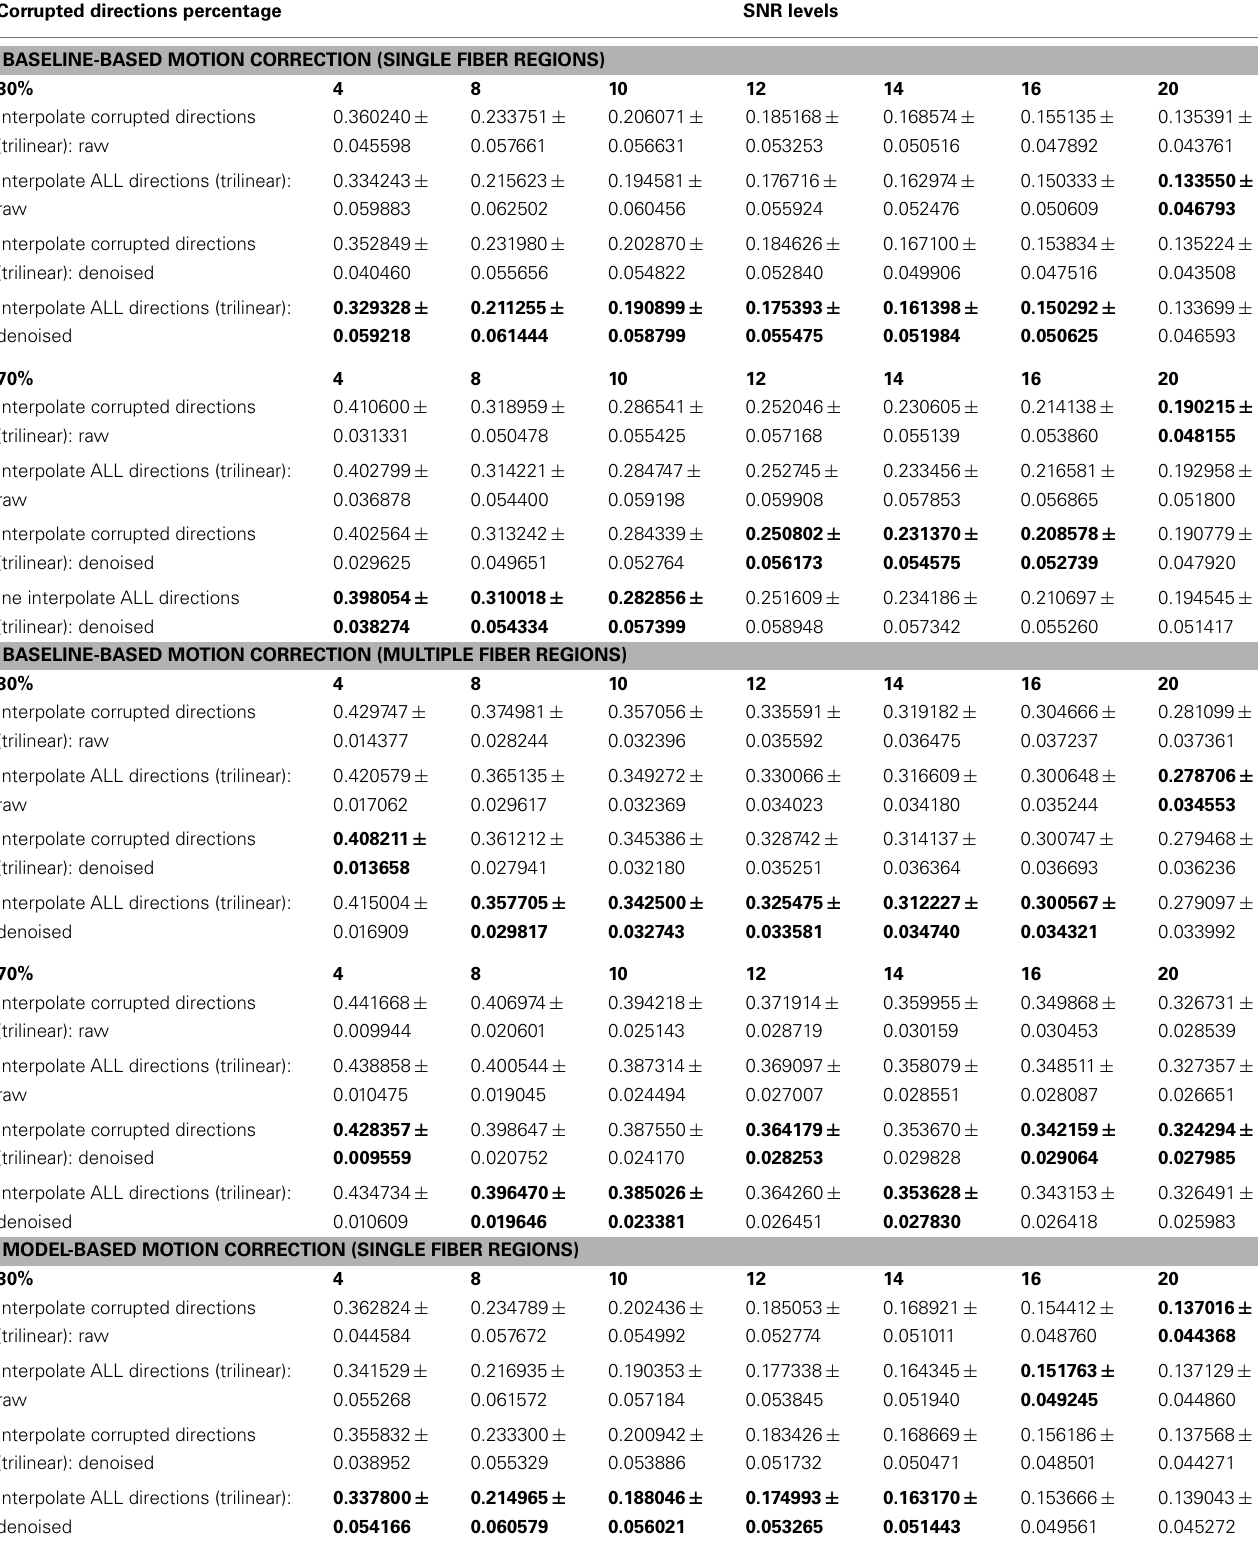
Table 1 |The effect of denoising on the average ± standard deviation of Jensen–Shannon divergence (JSD) values for single fiber regions and multiple fiber regions as a function of SNR levels for different motion corrupted percentages